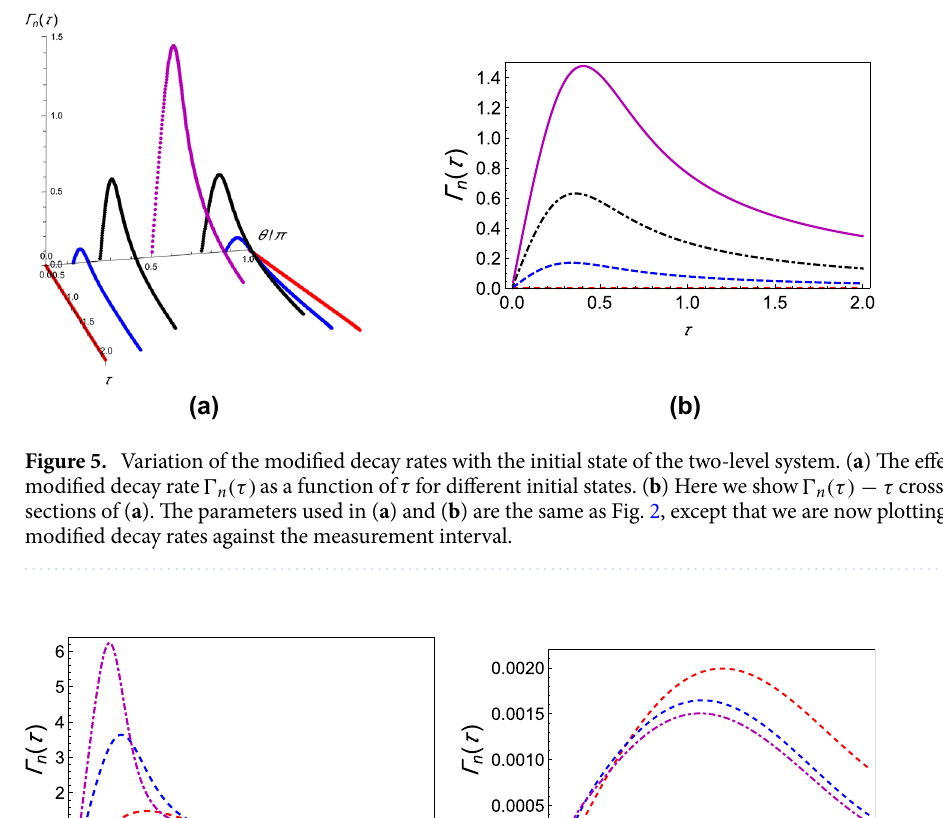
0 with different environment coupling π/ 2 and φ = = 0 and φ 0 with different coupling strengths. The = =